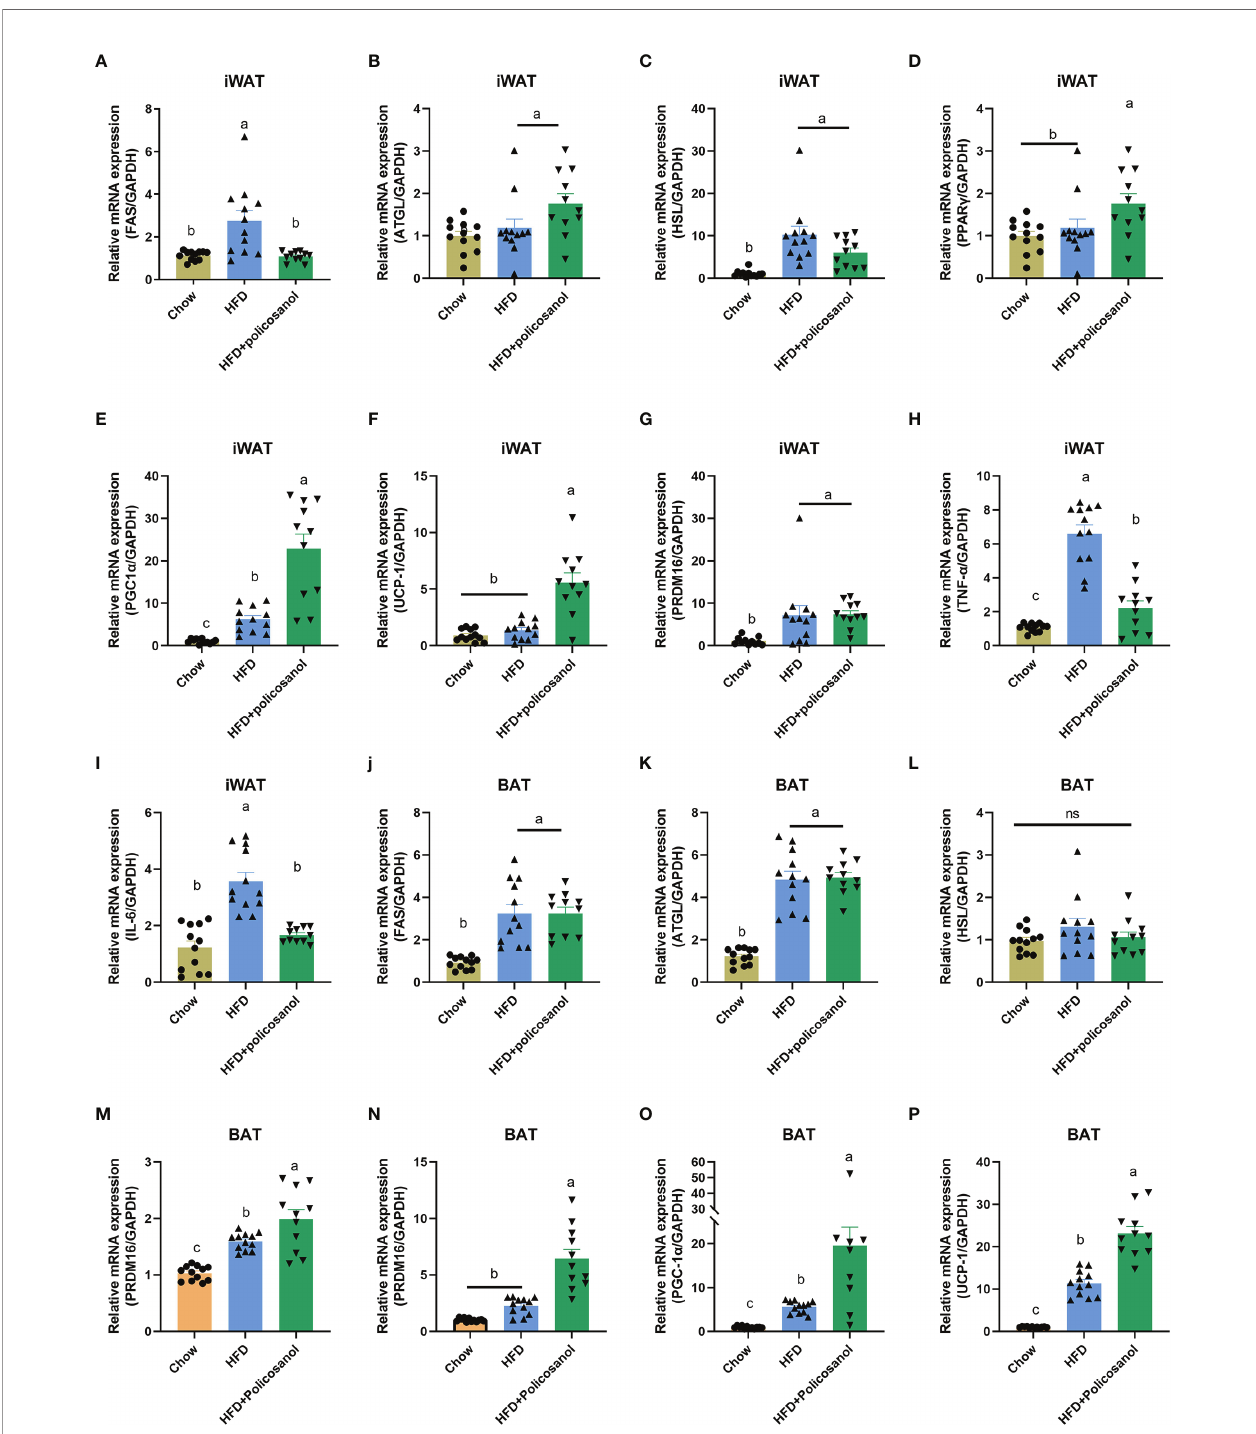
FIGURE 8 | Policosanol activates AMPK and downstream gene expression related to fatty acid synthesis, in fl ammation, lipolysis and thermogenesis in adipose tissue. (A – I) Relative mRNA expression in iWAT. (J – P) Relative mRNA expression in the BAT. Chow: The mice fed with chow diet (n=12), HFD: the mice fed with high fat diet (n=12), HFD+policosanol: The mice fed with high fat diet containing 0.5% policosanol (n=11). Differences of data in mice subjects were assessed by one-way ANOVA. For all pictures, columns indicated with different letters have signi fi cant difference, p < 0.05. ns, not signi fi